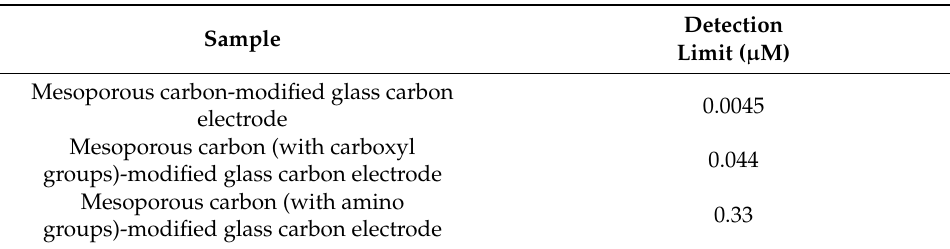
Table 7. The characteristic of modified electrodes.